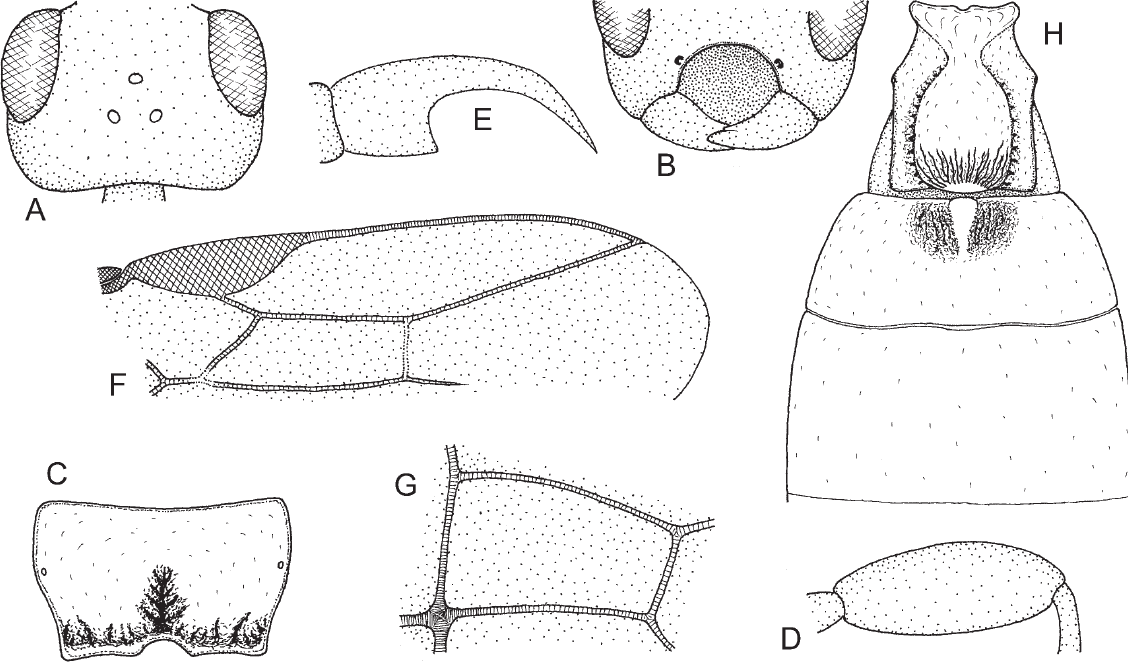
Fig. 14. Bracon ( Lucobracon ) grandiceps Thomson, 1894, ♀ lectotype. A . Head in dorsal view, B . Head in frontal view. C . Propodeum. D . Hind femur. E . Claw. F . Distal part of right forewing. G . First discal cell of right forewing. H . Tergites